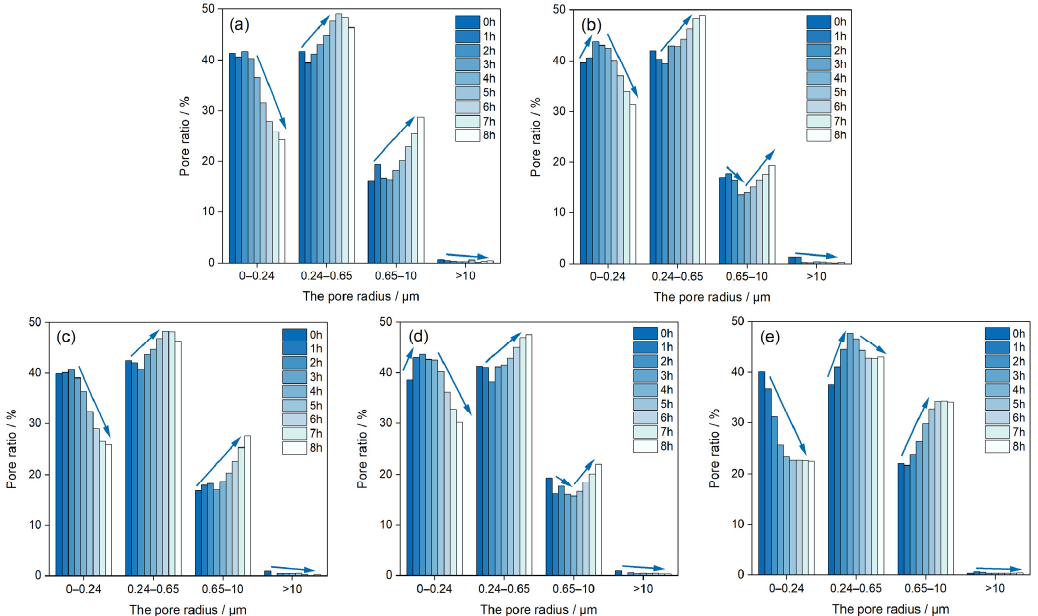
Figure 11. Distribution of internal pores of samples in the process of leaching with magnesium sulfate solutions with different pH: ( a ) pH = 2; ( b ) pH = 3; ( c ) pH = 4; ( d ) pH = 5; ( e ) pH = 6.